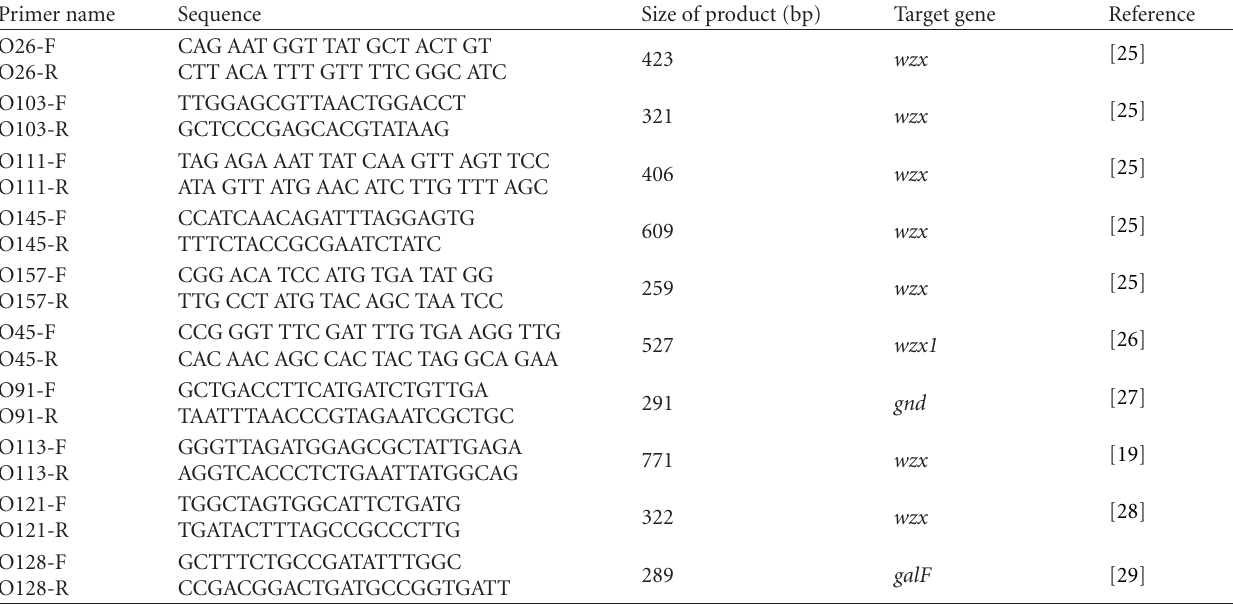
Table 1: Primer sequence for detection of STEC serotypes in animals milk and di ff erent traditional dairy